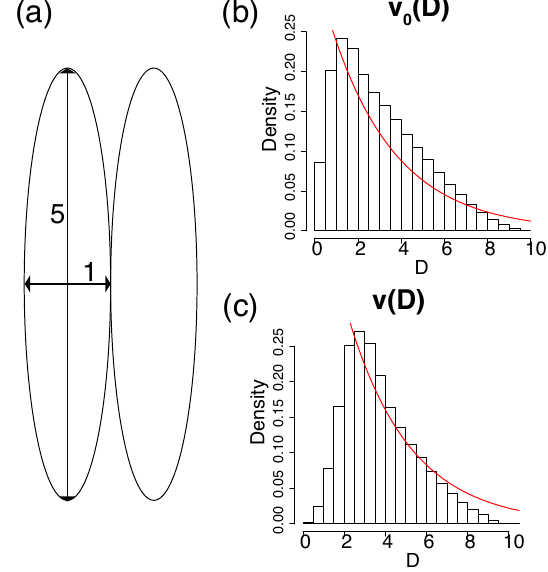
Figure 8. The probability density functions assumed in Eqs. (A6) and (A2) represent well the case of adjacent ellipsoidal watersheds illustrated in (a) . (b) displays the histogram of distance between two random points within a watershed, overlaid by a plot of Eq. (A6) with a 0 = 3 and a D = 1 / 3. (c) displays the histogram of distance between one random point on each watershed, overlaid by a plot of Eq. (A2) with a c = 1 /